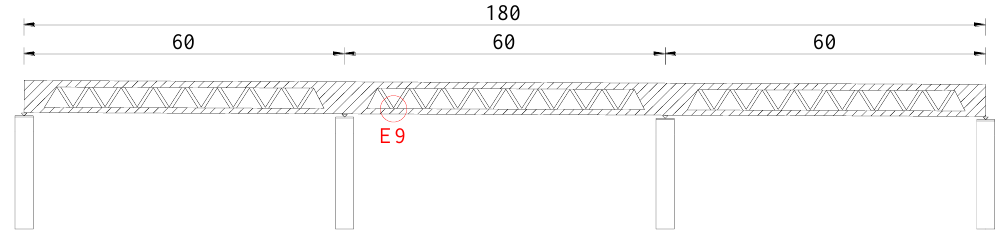
Figure 5. Layout of a steel–concrete composite continuous truss bridge (unit: m).